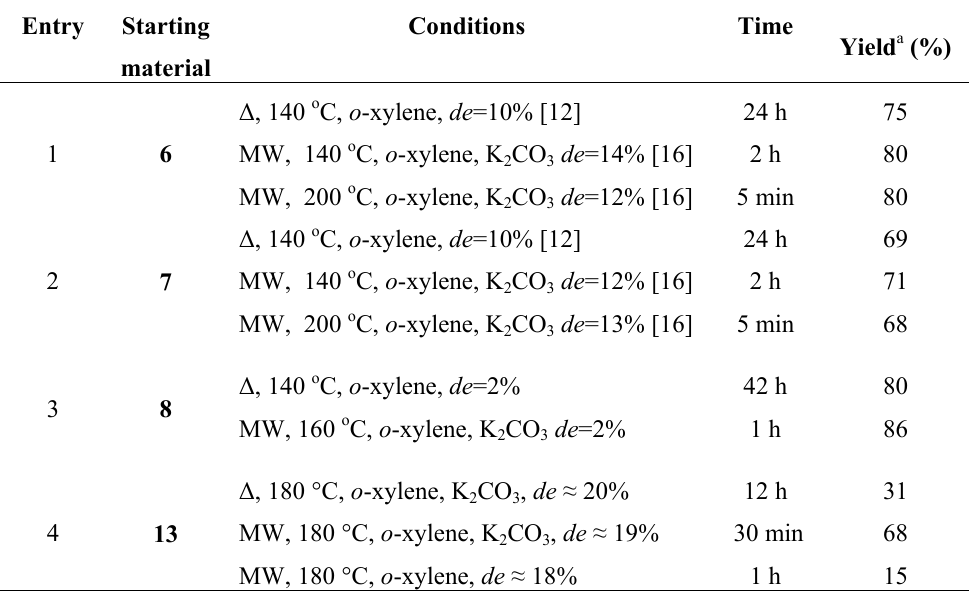
Table 2. Microwave accelerated Overman rearrangement of the chiral imidates 6 , 7 , 8 and 13